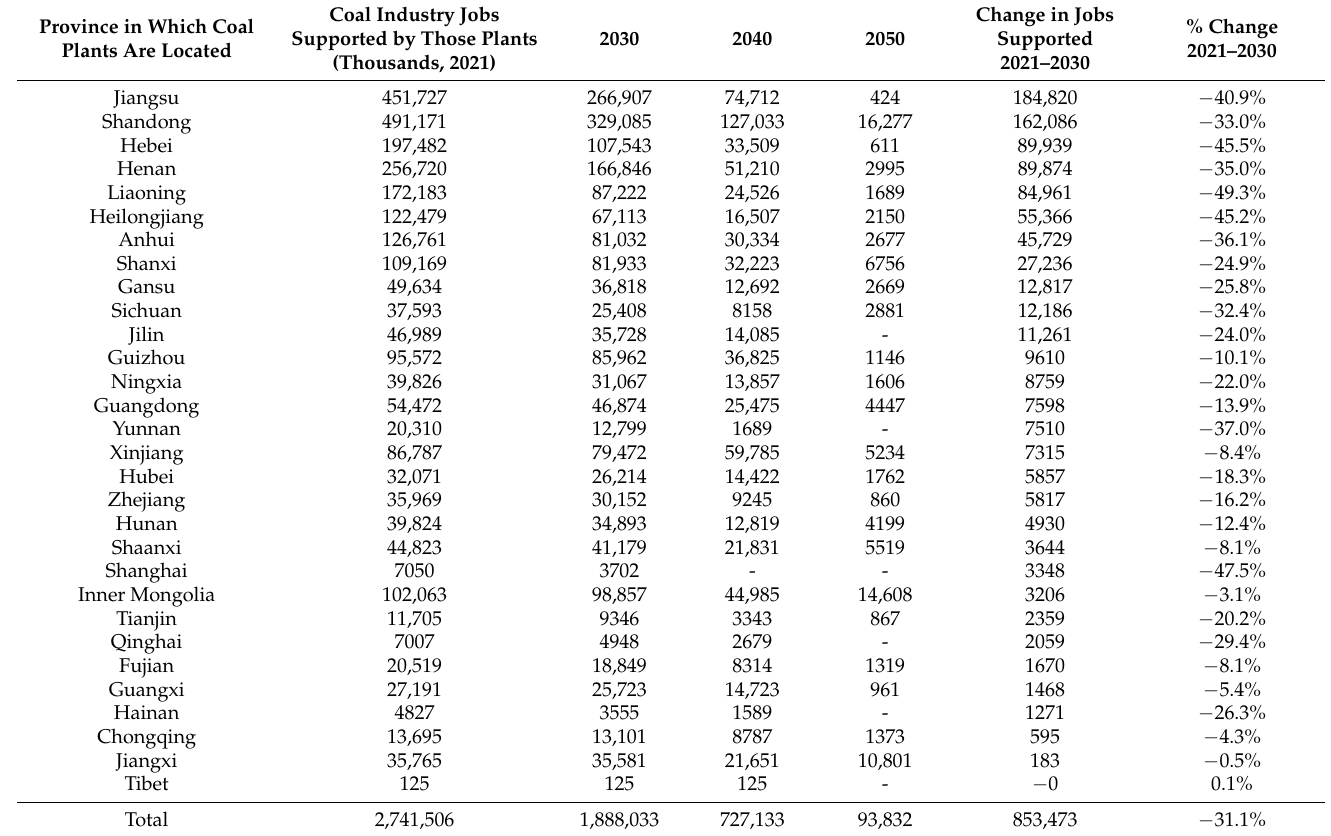
Table 3. Trends in coal industry employment supported by each province, 2021–2060 and change to 2030 (B